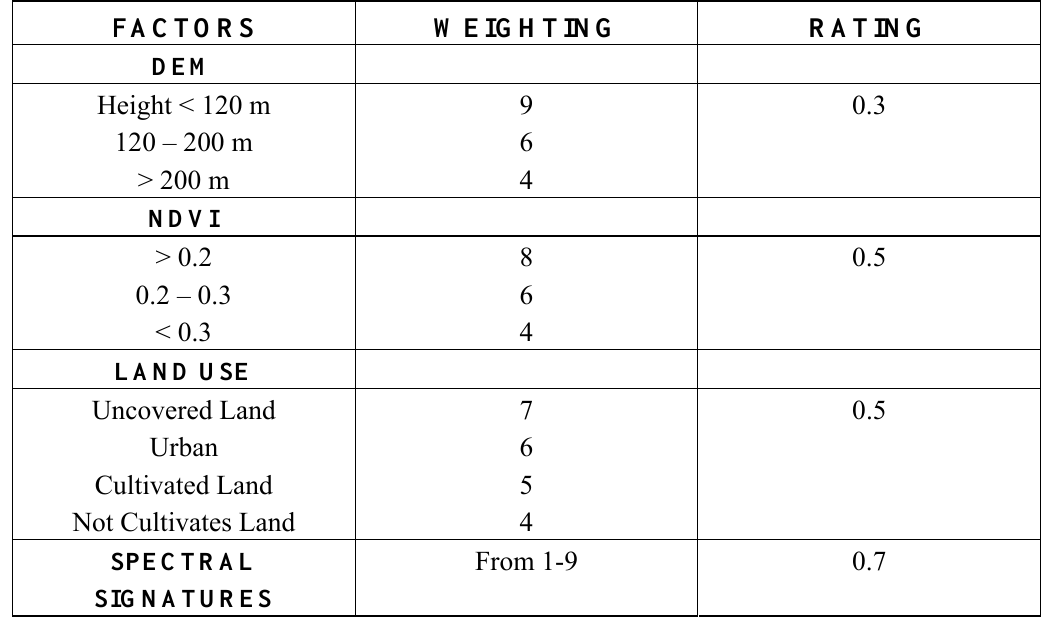
Table 5. Weights and rating for each